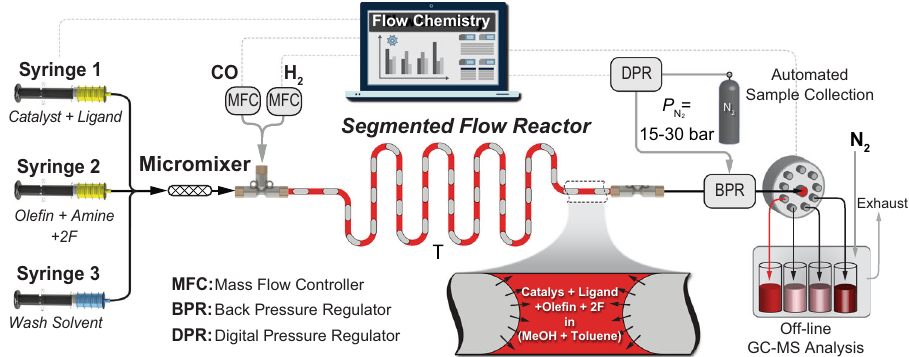
Fig. 2 Schematic illustration of the fl ow chemistry platform utilized for the accelerated HAM reactions. The sample collection chamber allows for liquid sampling at different reaction (residence) times by varying the total feed fl ow rate. MFC: Mass Flow Controller, BPR: Back Pressure Regulator, DPR: Digital Pressure Regulator, 2F: 2- fl uoro-4methylbenzoic